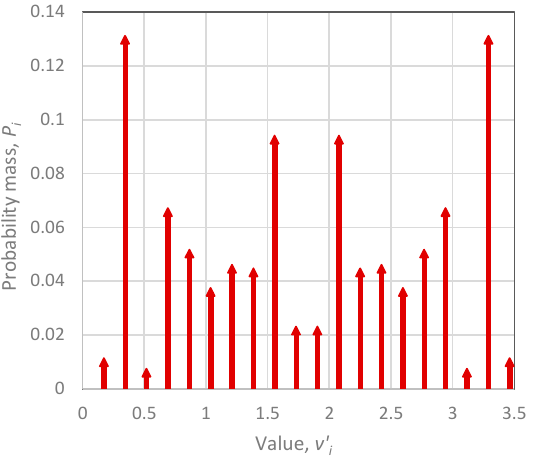
Figure 4. Probability mass function of the discretized white noise used in the simulation application for a synthetic example of an antipersistent FHK process with uniform distribution.